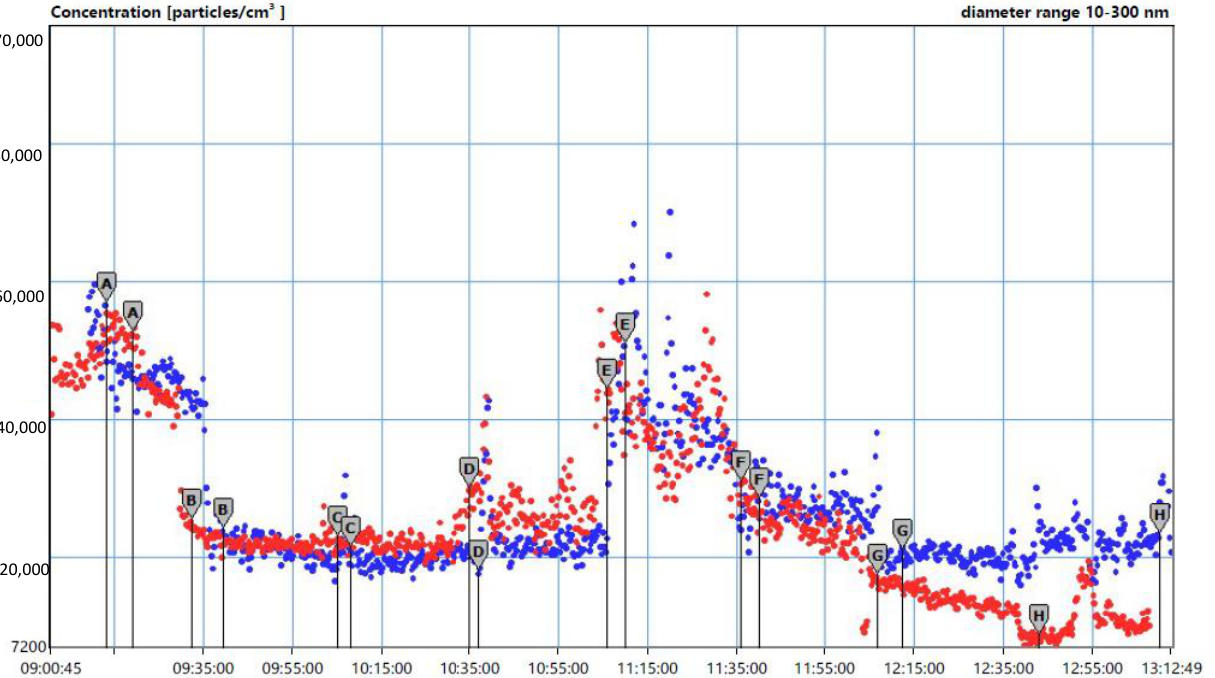
Figure 1. Time course ( X -axis) of particle number concentrations ( Y -axis) in the 10–300 nm dimen- sional range: first day (blue bullet) and second day (red bullet) of the sampling. A–H markers refer to the different working areas assessed in two subsequent days. A = TiO 2 storage area (confined area used as positive control); B = water-based paint system; C = water-based paint system during automatic bin filling; D = water-based paint system during manual bin filling; E = manual handling of powders, mixing and dispersion; F = manual handling, mixing and dispersion; G = office building; H = outdoor environment (NB: the first day there was one truck to supply the silos with TiO 2 ). The median value of the respirable fraction of dusts was 0.064 mg/m 3 in the